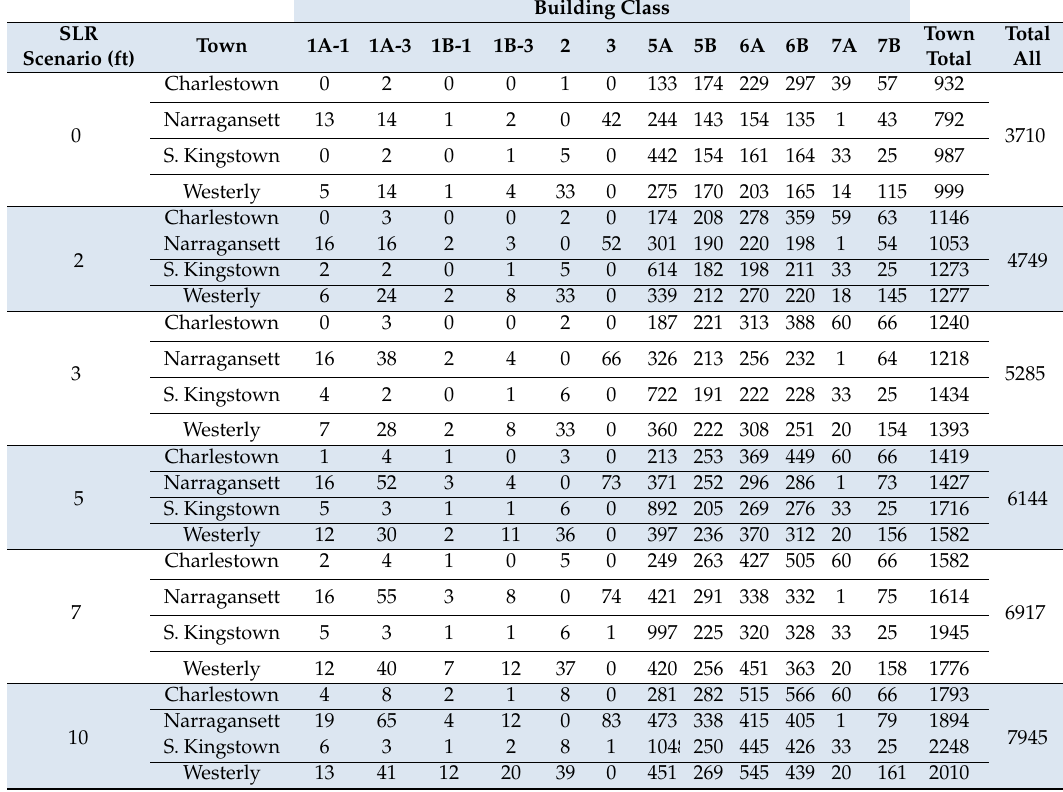
Table 4. Number of structures, by prototype class, impacted by the 100 yr storm surge with SLR values from 0 to 10 ft for the Towns of Charlestown, Narragansett, South Kingstown, and Westerly,